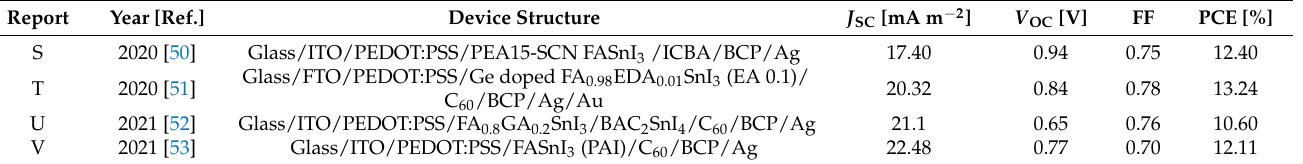
Table 8. Record table containing the reported Sn-PSCs and the corresponding photovoltaic parameters mentioned in Section